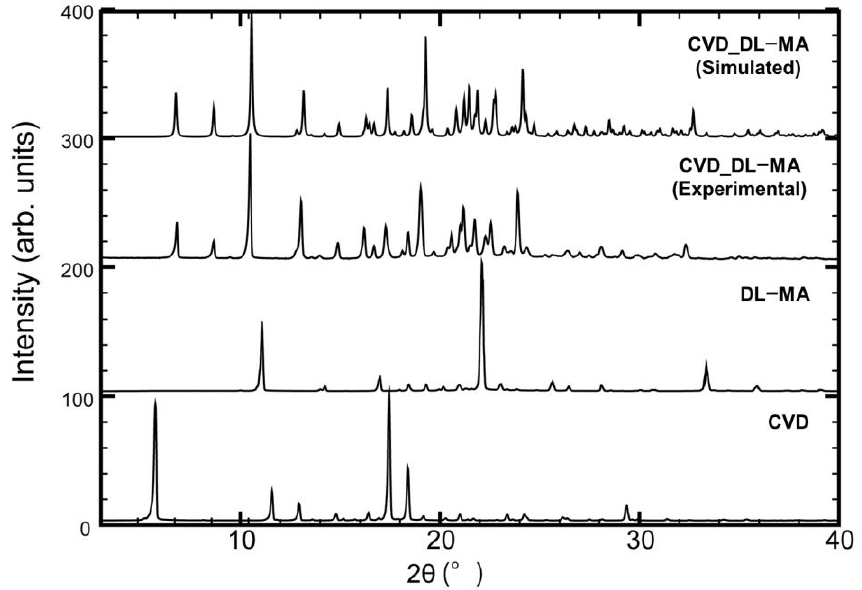
Figure 8. PXRD patterns of CVD_DL-MA (simulated), CVD_DL-MA (experimental), DL-MA, and CVD.